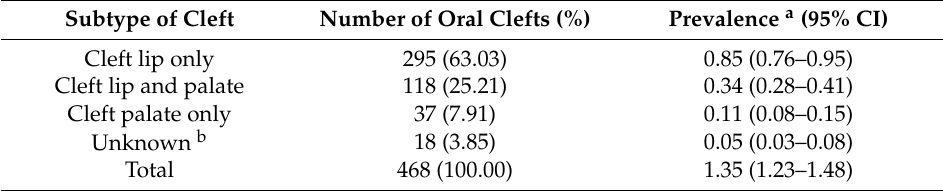
Table 1. The prevalence and relative proportions (%) of oral clefts in 2008 in Gansu